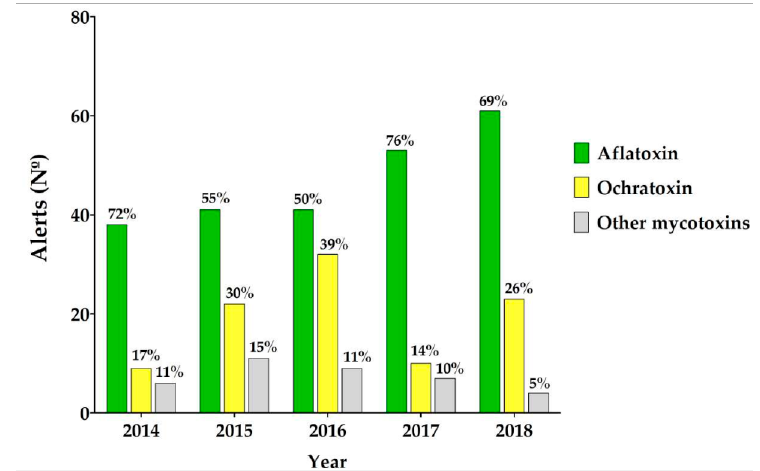
Figure 1. Number and relative percentage of mycotoxin alerts reported during the last five years (2014–2018) by the Rapid Alert System for Food and Feed (RASFF, 2019).